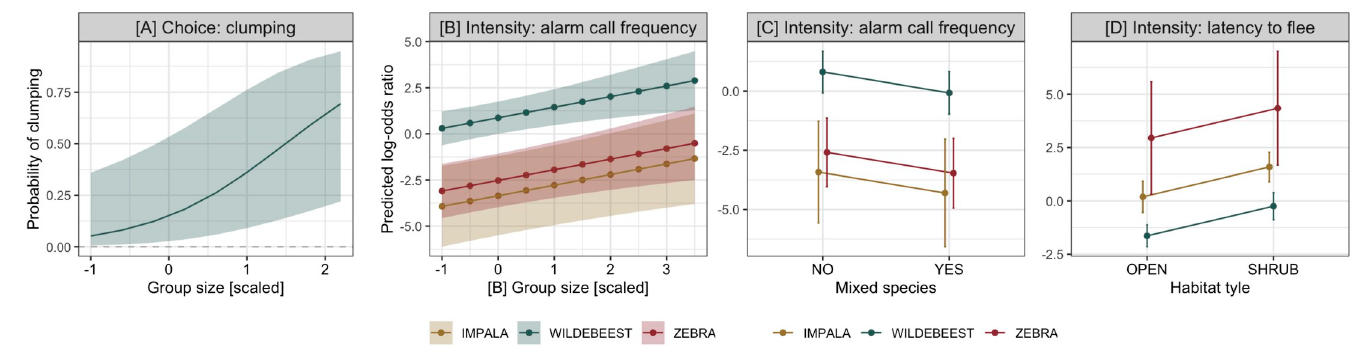
Fig 3. Strongly supported effects of social and environmental variables on anti-predator decision-making. [A] Wildebeest were more likely to form defensive clumps when more conspecifics were present. In all three focal species [B] alarm-calling frequency increased with group size, [C] alarm-calling frequency decreased when heterospecifics were present, and [D] flight occurred sooner in experimental trials that took place in closed habitats. Baseline performance of these behaviors was higher in wildebeest than in zebra and impala for alarm-call frequency [B, C] and lower for latency to flee [D] . Probability of behavioral response and log-odds ratio for choice [A] and intensity [B-D] of responses, respectively, are depicted with associated 95% CIs.